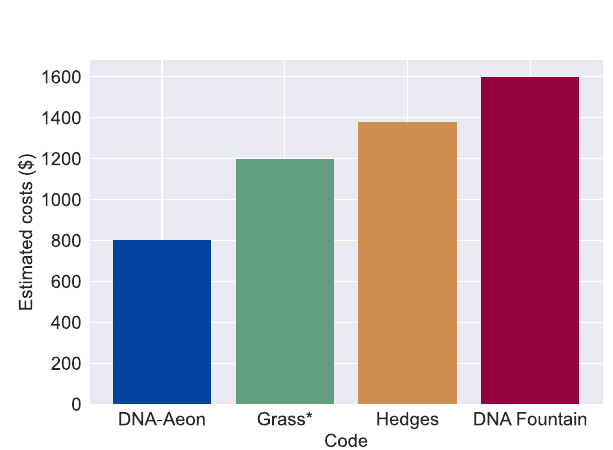
Fig.3|Costevaluation:estimatedsynthesiscostsofencodinga4.8KB fi lewith enough redundancy to successfully decode it after synthesizing, in vitro sto- ragefortenyears,andsequencing.